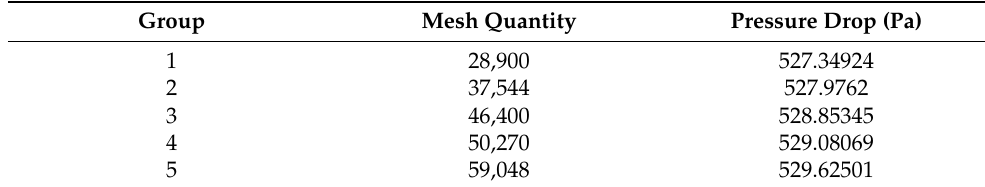
Table 3. Mesh independence verification.